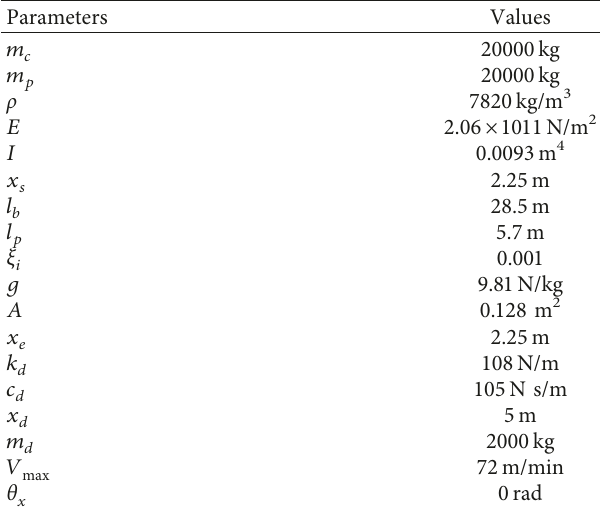
Figure 9: Consistency comparison of calculated results to Refer- ence [31]. Table 4: Parameter values of the rigid flexible coupling system of the casting crane